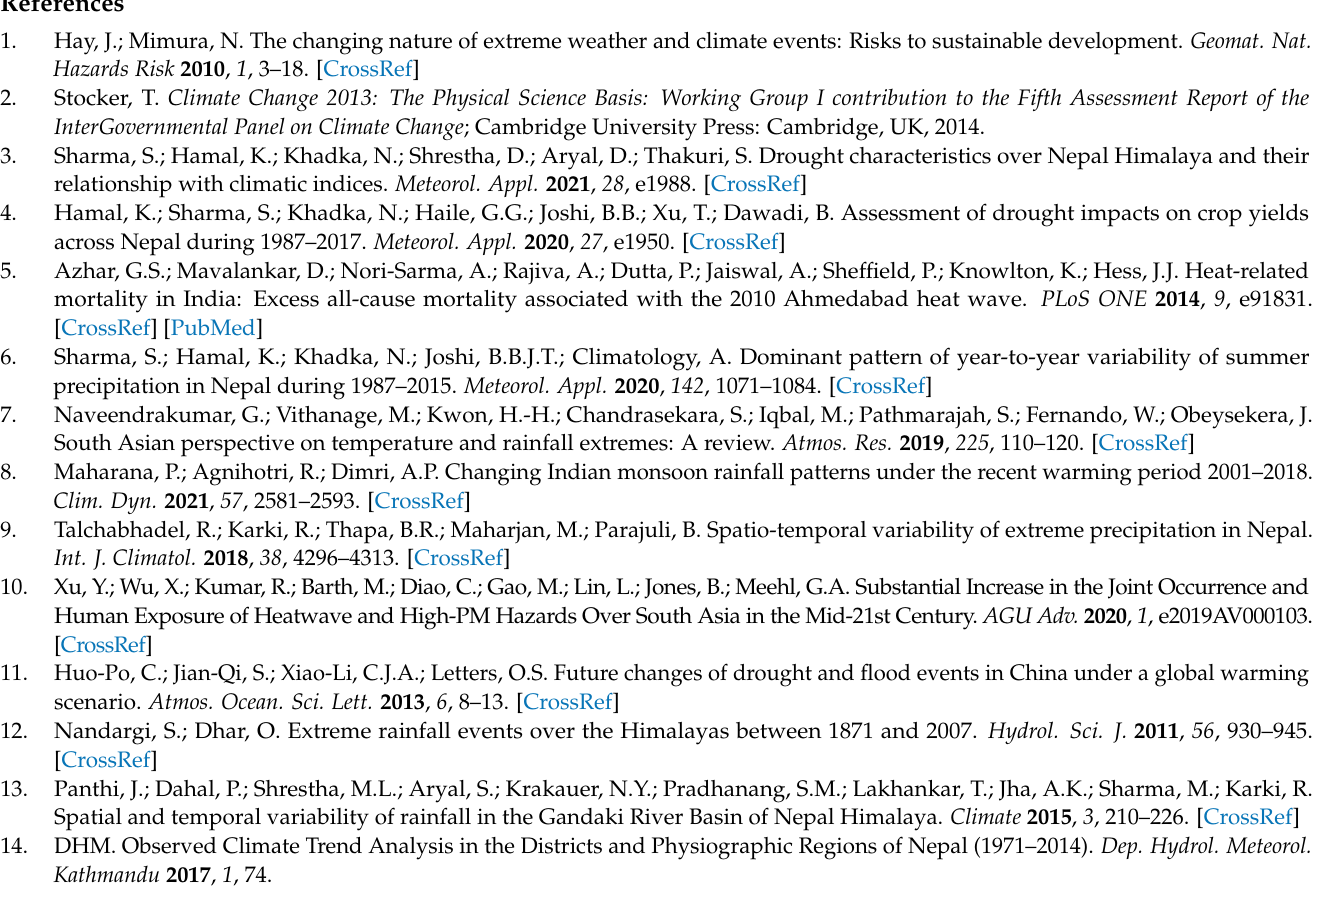
Figure A3. Performance comparison of minimum temperature from ( a , b ) observation and 13 CMIP6 models and ( c , d ) observation and mean ensemble of 13 CMIP6 models. Black dash line in panel b and d represents the 1:1 line. Note: Ensemble members in panel a and b are represented by same color.